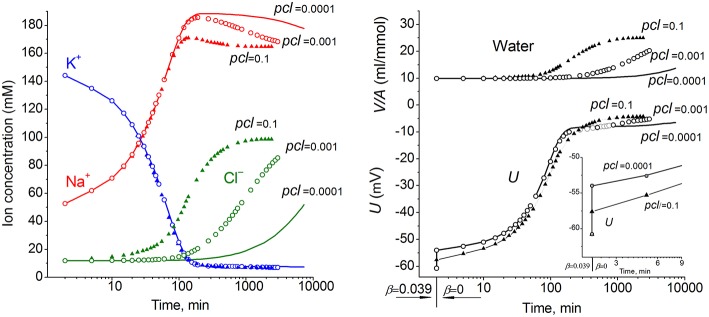
The effect of pCl on the time course of the ion and water balance disturbance caused by turning off the pump. The data were calculated by using the software BEZ01B with the following parameters: na0 140, k0 5.8, cl0 116, B0 48.2, kv 1, na 52.6, k 144.2, cl 11.9, beta 0 (at the initial balanced value of 0.039), gamma 1.5, pna 0.006, pk 0.06, pcl 0.1 (triangles) or 0.001 (circles) or 0.0001 (solid lines), inc = ikc = inkcc = 0, kb 0.